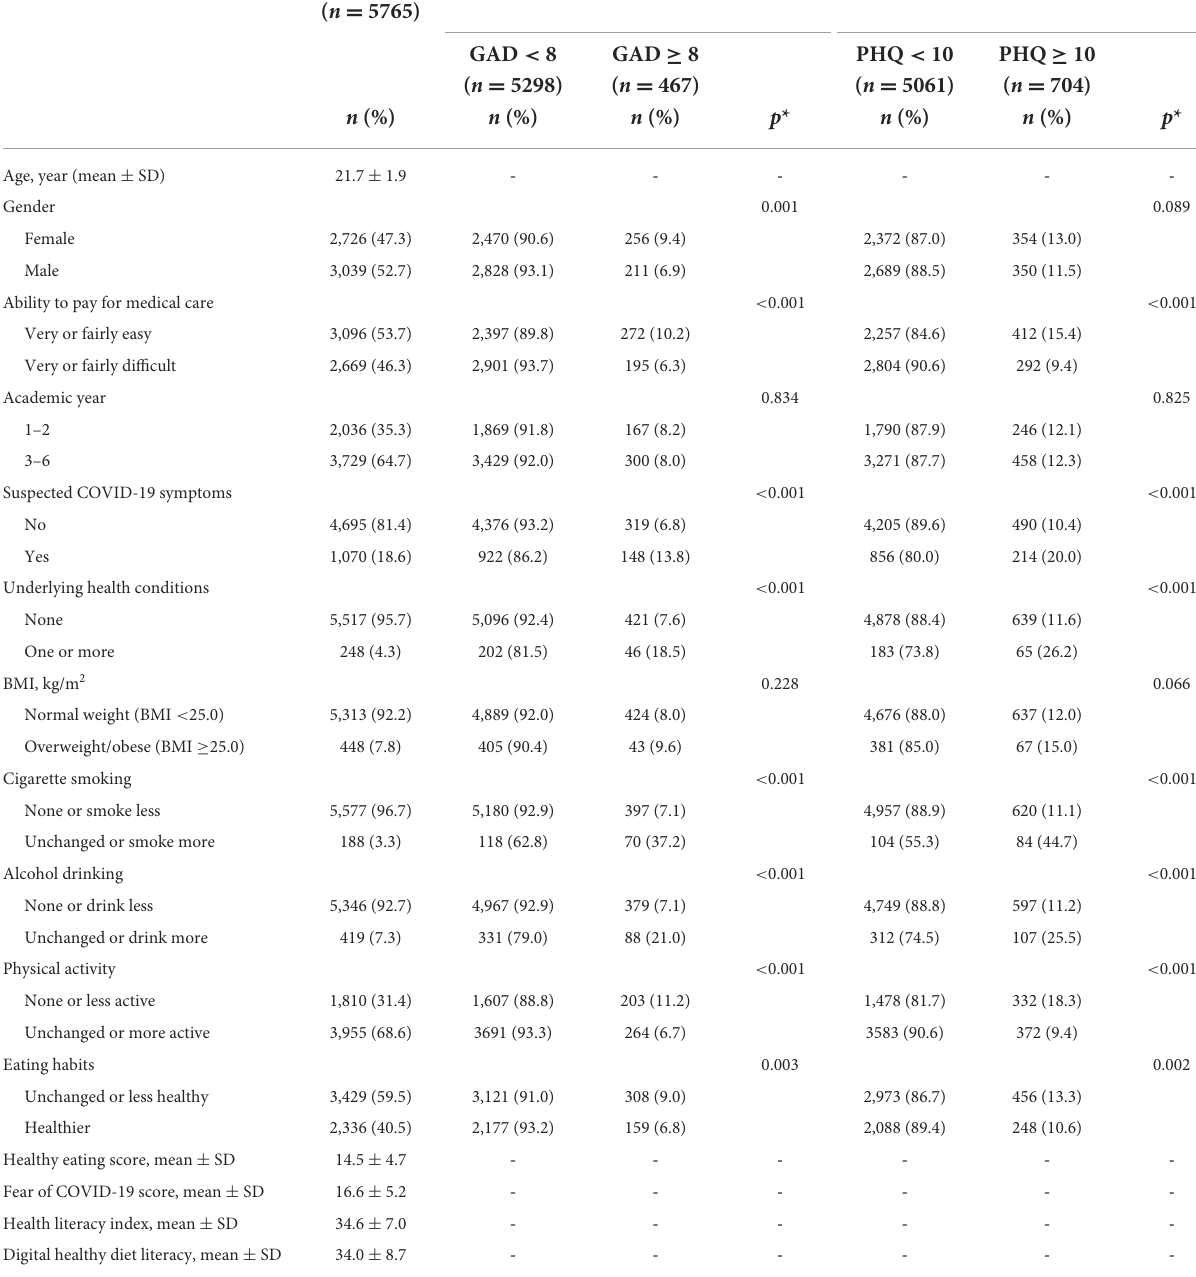
TABLE 1 Characteristics of medical students by anxiety and depression ( n =